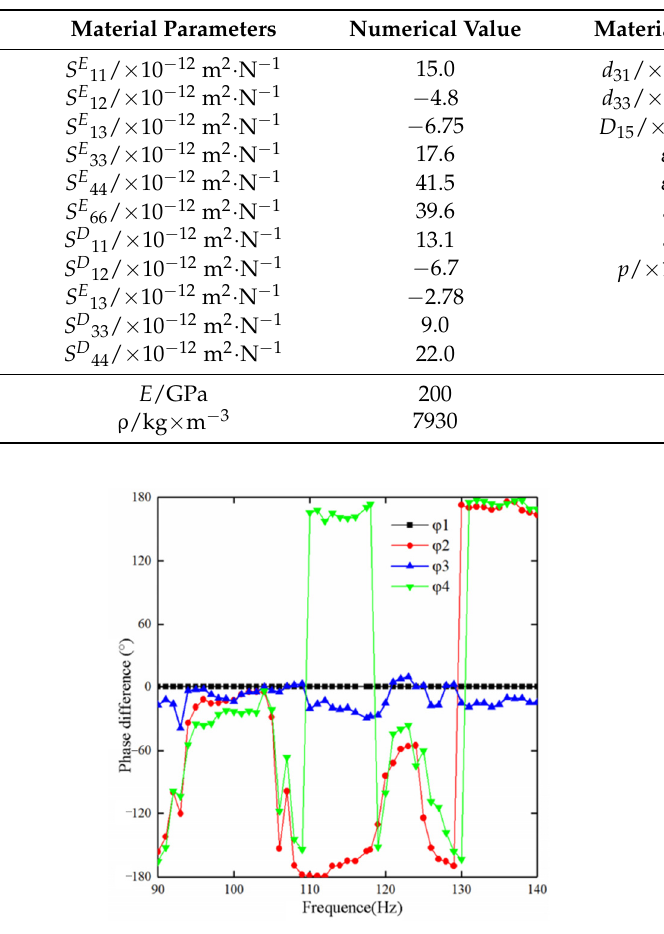
Figure 6. Voltage phase relationship of the four outputs.